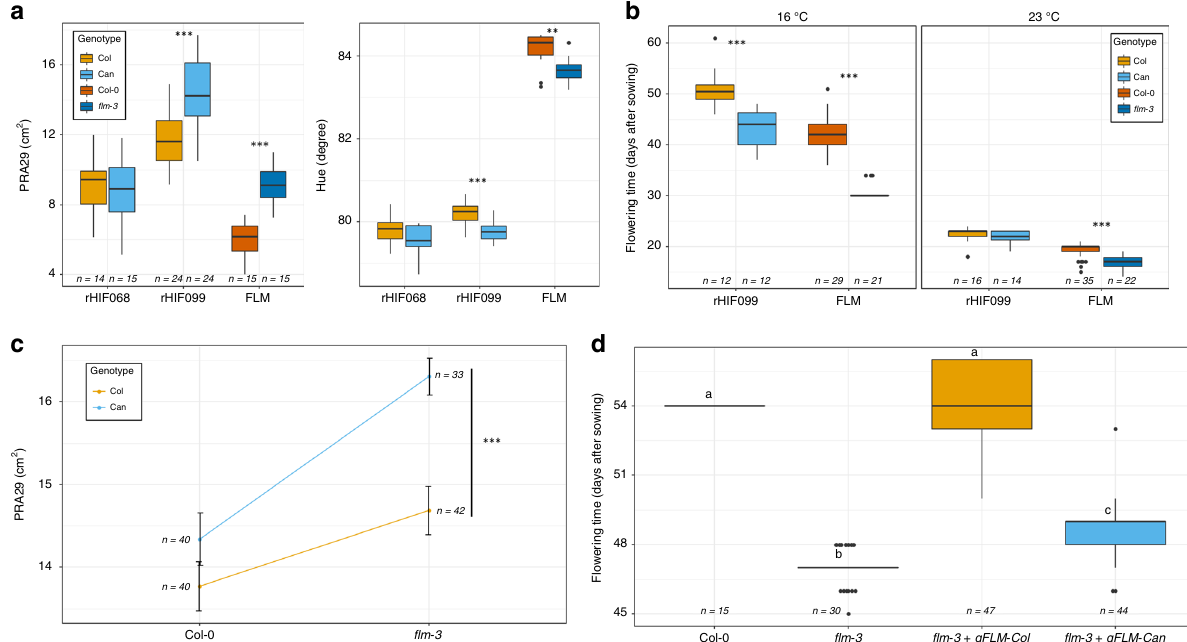
Fig. 1 Natural variation at FLM is responsible for the QTLs observed at the end of chromosome 1. a Boxplots comparing PRA29 or Hue in alternate fi xed alleles at the segregating region of the two most informative recombinant lines (rHIF068 is fi xed at FLM but segregates elsewhere, and rHIF099 is segregating at FLM , see their exact genotype in Supplementary Data 4), and in fl m-3 versus its wild-type background Col-0. b Modulation of fl owering time according to the growth conditions at 16 and 23 °C (in long days) in rHIF099 lines and fl m-3 versus Col-0. c Quantitative complementation assay assessing the effect on PRA29 of each of the possible genotypic combination between the Can or Col alleles at the QTL (in the rHIF background) and the wild-type or mutant ( fl m-3 ) alleles at FLM (in the Col-0 background). PRA29 was obtained using the Phenoscope . Error bars indicate the standard error of the mean. Signi fi cance is shown for the effect of the QTL allele in complementing fl m-3 . d Functional complementation based on fl owering time of the fl m-3 mutant transformed with the genomic fragments of FLM ( gFLM ) from Col-0 or Can-0. Source data are provided as a Source Data fi